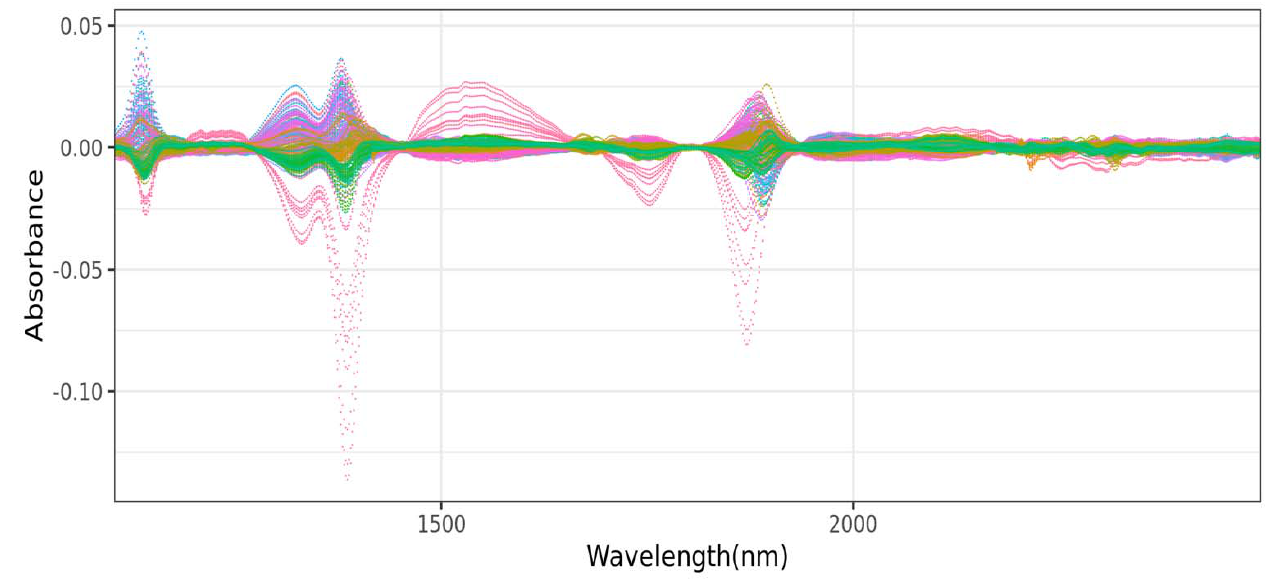
Figure 2. Near ‐ infrared spectra of fresh homogenized cattle and poultry manure samples as shown in different line colors.